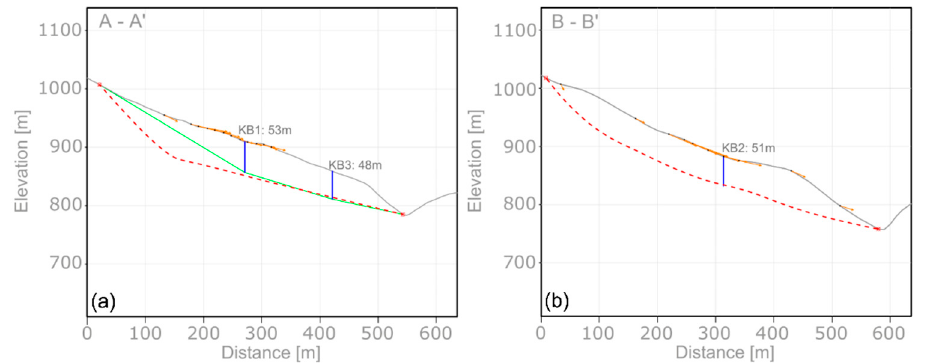
Figure 12. VIM results for the A-A’ ( a ) and B-B’ ( b ) cross sections, landslide surface (red dotted line), landslide surface produced by [23] (green dotted line), boreholes position (blue lines), and MSBAS data (orange vectors).